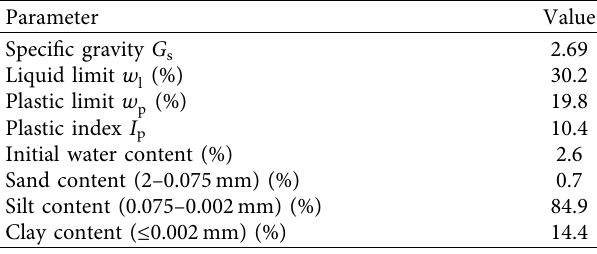
Table 1: Physical properties of soils used in this study.